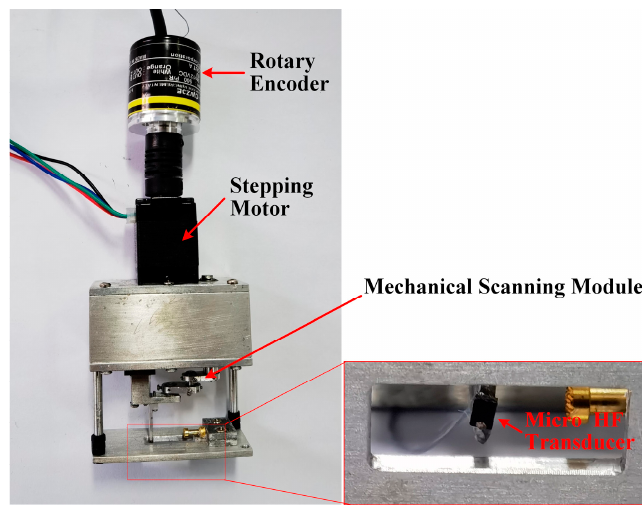
Figure 5. The fabricated mechanical scanning system.